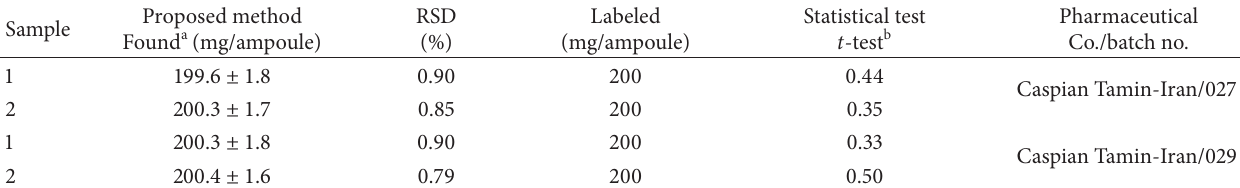
Table 3: Determination of dopamine in dopamine injection solution using the developed procedure.